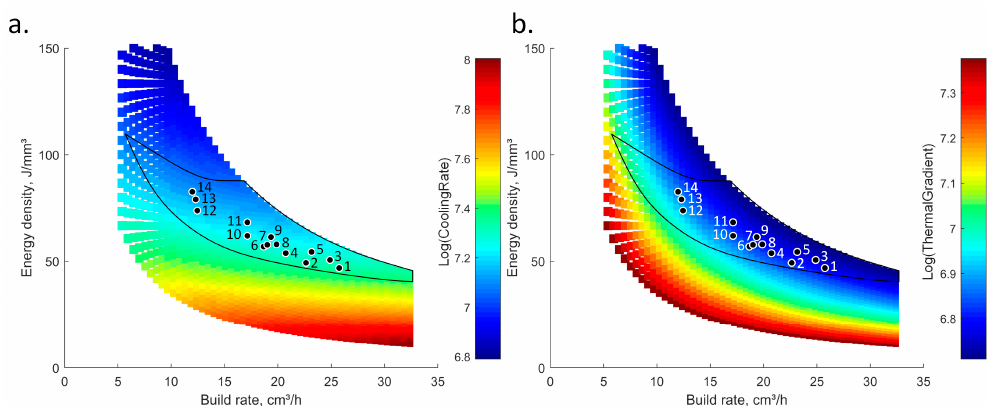
Figure 5. ( a ) Cooling rate and ( b ) thermal gradient processing maps for iron powder; contours delimit the processing conditions corresponding to a printed density ≥ 99.9%; dots identify 14 printing condition sets used for model calibration.